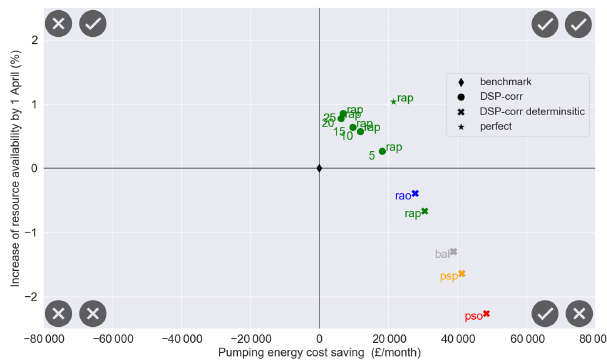
Figure 5. Post-evaluation Pareto fronts representing the average system performance (over period 2005–2016) of the real-time opti- mization system during the pumping licence window (1 November– 1 April) with respect to the benchmark (black diamond), using the bias-corrected forecast ensemble (DSP-corr) with different ensem- ble size and the mean of the forecast ensemble (DSP-corr determin- istic). For practical purposes, only the resource availability priori- tized scenario (rap) is represented for the DSP-corr. The annotation numbers refer to the ensemble